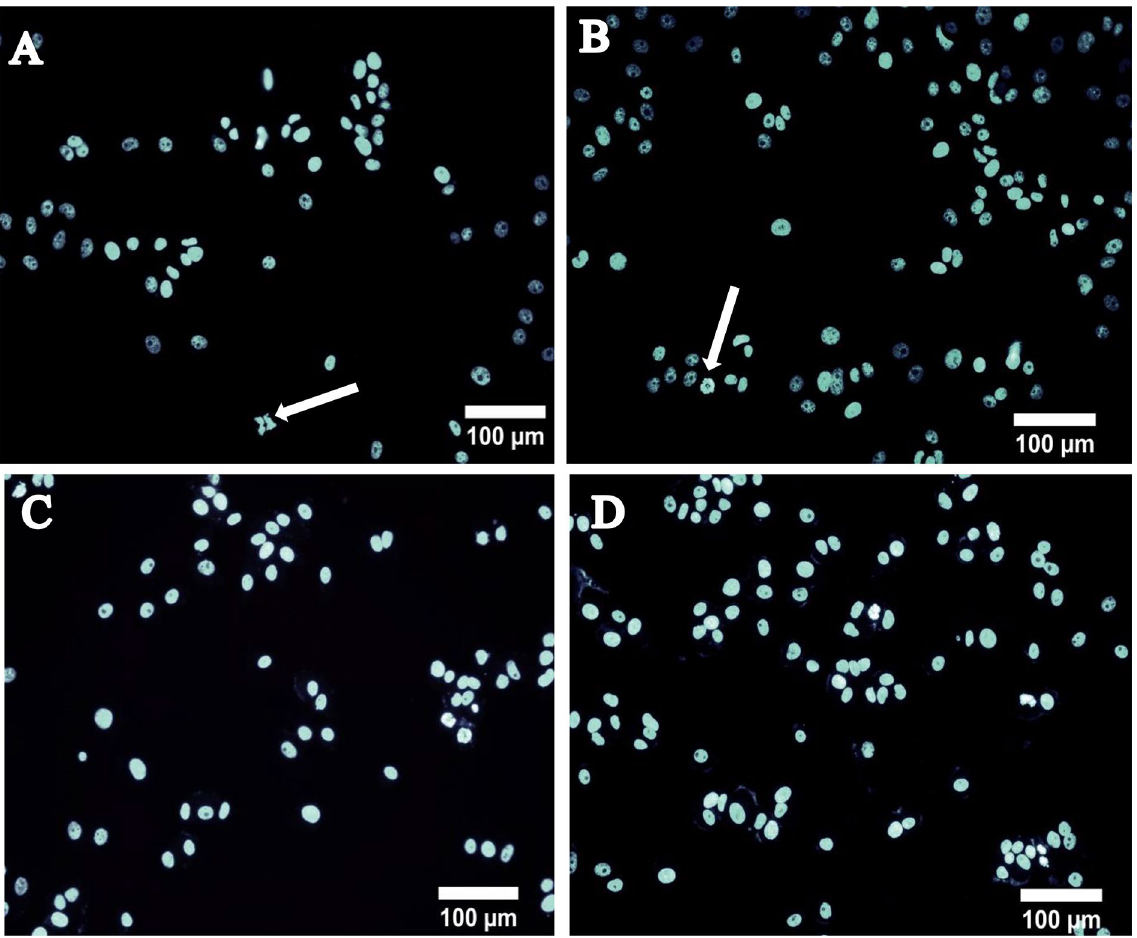
Figure 7. DAPI stained fluorescent images of MCF-7 cells treated at a concentration of 40 µM for 24 h, ( A ) CUR-NPs 7:3, ( B ) CUR-NPs 6:4, ( C ) CUR only, ( D )